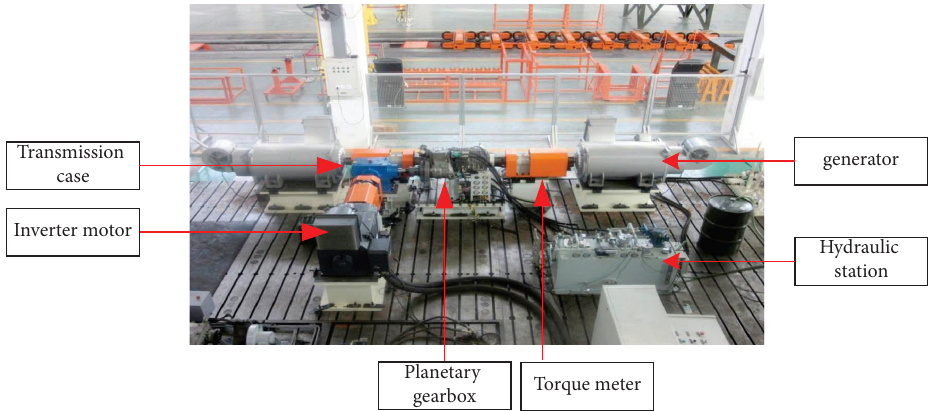
Figure 9: Test bench of the planetary gearbox.